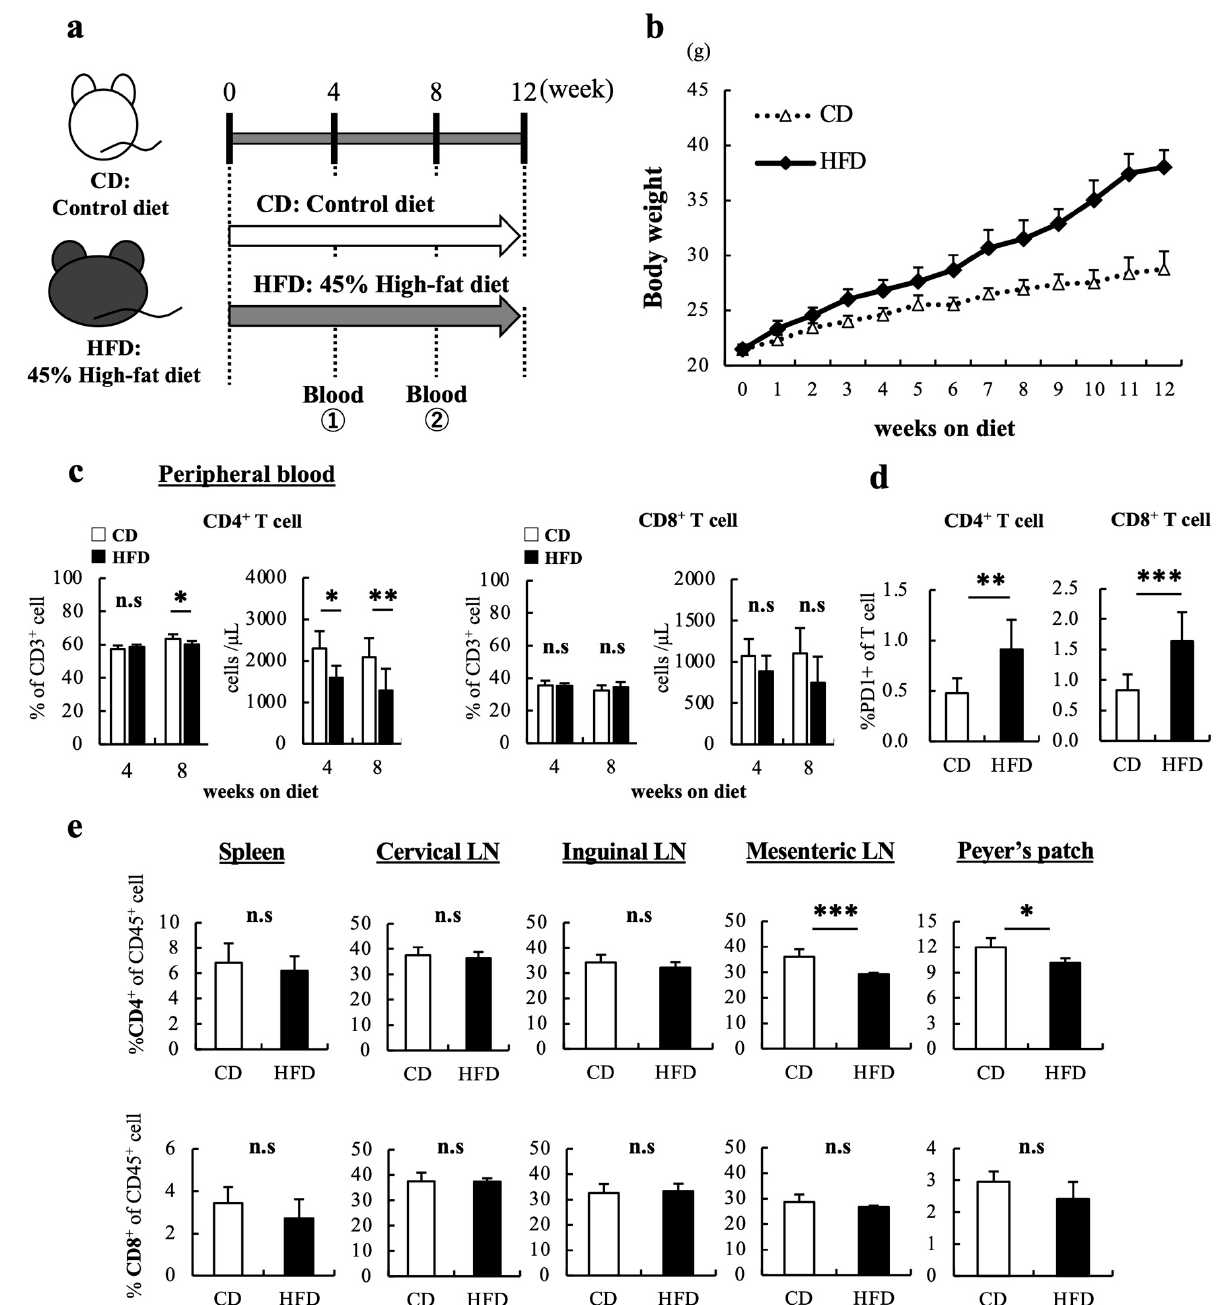
Figure 1. High-fat diet (HFD)-induced obesity reduced CD4+ cells in the peripheral blood and gut-associated lymph nodes of mice. ( a ) Experimental schema is shown. Male mice were fed a HFD (45% calories from fat) or CD (10% calories from fat) for 12 weeks. ( b ) The change in body weight of mice fed the CD and those fed the HFD was measured. ( c ) Blood sample was obtained from the buccal vein, and changes over time in the number and percentage of T cells in the peripheral blood were analyzed at 4 and 8 weeks. ( d ) PD-1 expression in T cells in peripheral blood at 8 weeks are shown. ( e ) Percentage of T cell in CD45+ cells in secondary lymphoid tissues at 12 weeks are shown. The data are expressed as the mean ± standard deviation (S.D.) (( a – d ), n = 20 mice in each group; ( e ), n = 10 mice in each group). Student’s t -test was performed for two-group comparisons. * p < 0.05, ** p < 0.01, *** p < 0.005. HFD, High-fat diet; CD, Control diet.